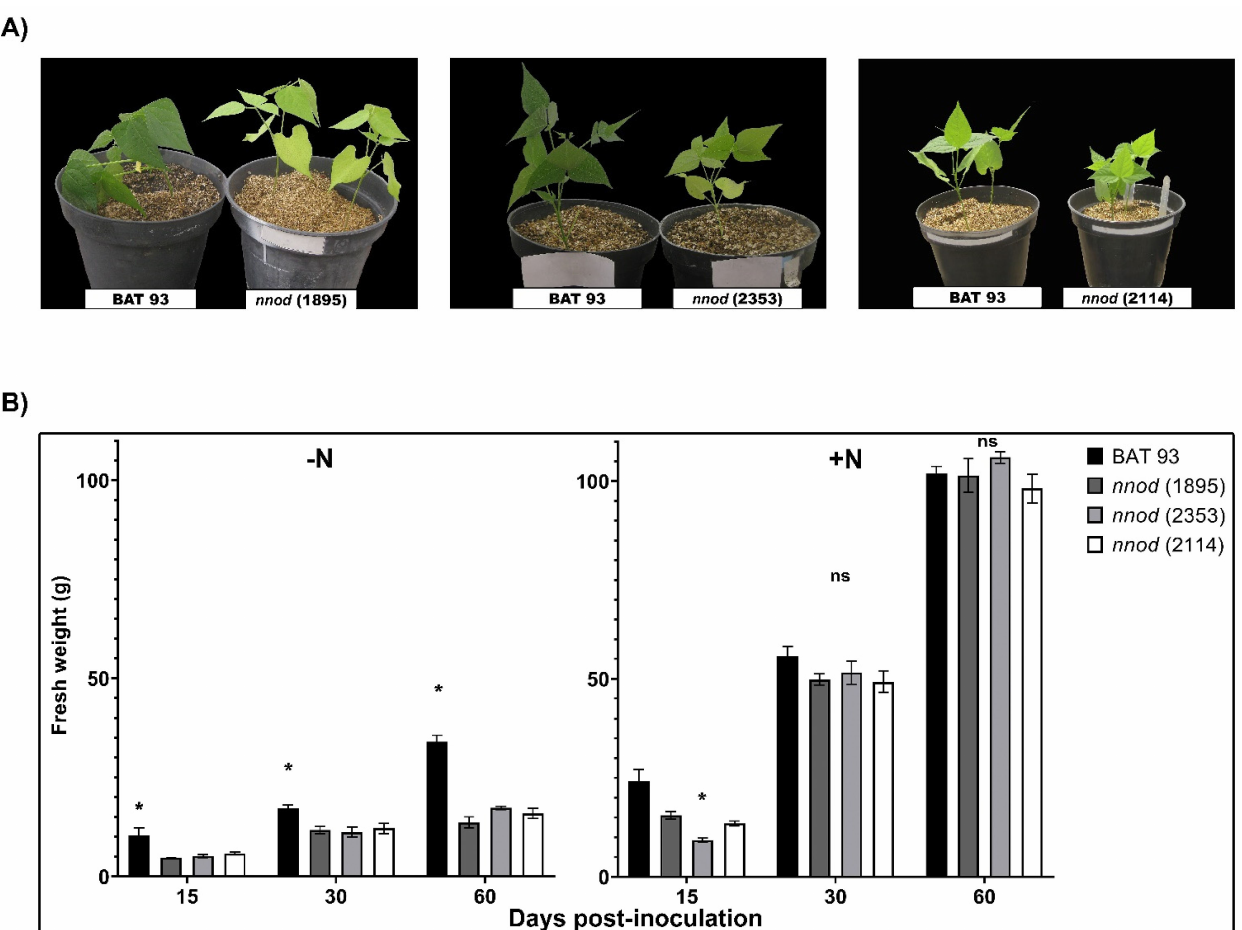
Figure 1. Phenotype of the Phaseolus vulgaris non-nodulating mutants: nnod (1895), nnod (2353) and nnod (2114). ( A ) Representative plants of wild type (WT) BAT 93 (left) and each of the non-nodulating ( nnod ) mutants (right), after 25 days post-inoculation (dpi) with Rhizobium etli CE3. ( B ) Growth, calculated as fresh weight (g), of WT in comparison to nnod mutants, watered with N-free solution and inoculated with R. etli CE3 (left) or watered with full-nutrient solution (7 mM N-content, right). The data are presented as average from at least 5 individual plants with standard error (SE) as indicated by error bars. (*) significant difference in fresh weight between WT and each nnod mutant-inoculated root; (ns) no significant difference ( p ≤ 0.05, Student’s t